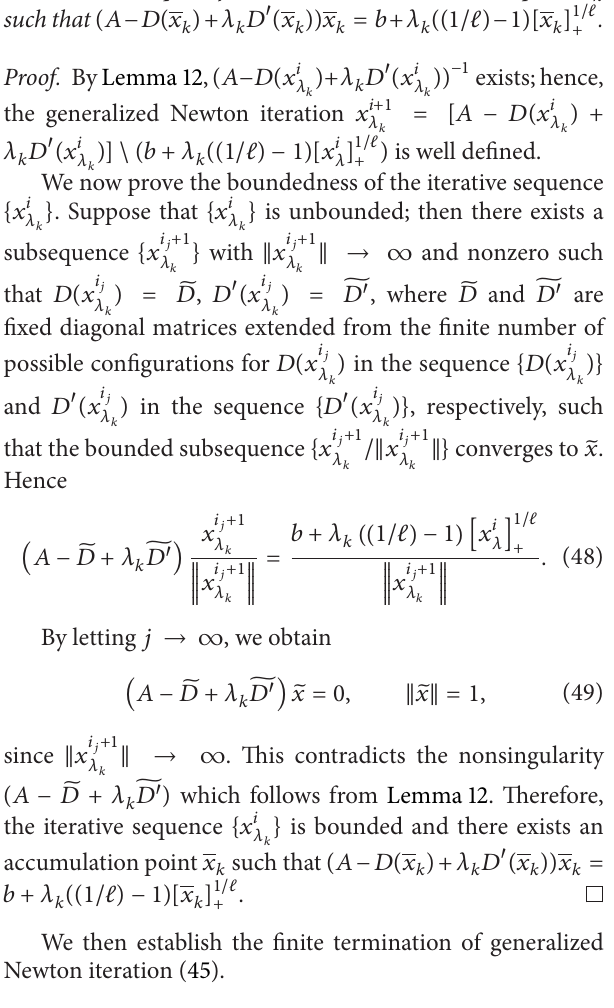
Algorithm 11 (penalized-equation-based generalized Newton algorithm). We have the